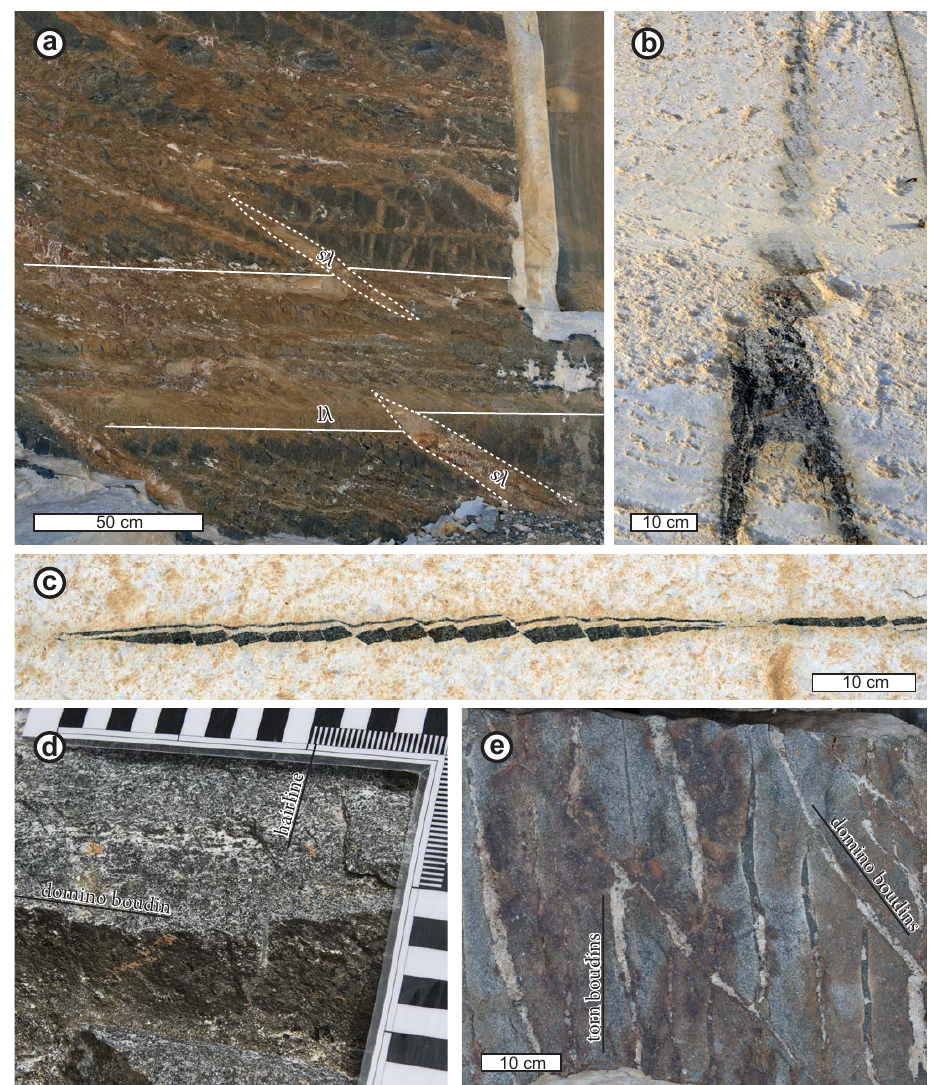
Figure 10. Outcrops showing clear age relationships between the structures. (a) Wall exposure of an amphibolite with intersecting lλ and sλ pinch-and-swell structures (view to east). Sλ pinches (dashed lines) displace the long axis of lλ and have identical orientation in both lλ swells and pinches. Sλ is therefore younger than lλ . (b) Elongated fold hinge displaced by domino boudins (view to south). (c) Domino boudinage of an older sλ pinch. Note the change of spacing of domino boudins as the amphibolite thins out in the pinches. (d) Oblique view on a domino boudin slip plane crosscut by chlorite-filled hairline veins. Hairline veins are the youngest structures in the amphibolite, crosscutting all other structures (see also Figs. 6d, 7c). (e) Torn boudin necks filled with calcite and chlorite abut and deflect at pre-existing domino shear